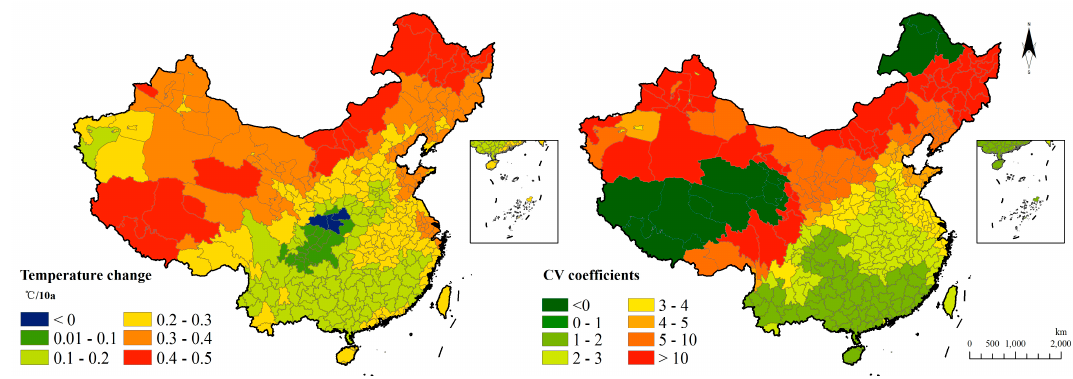
Figure 3. Temperature change and fluctuation in 60 years.